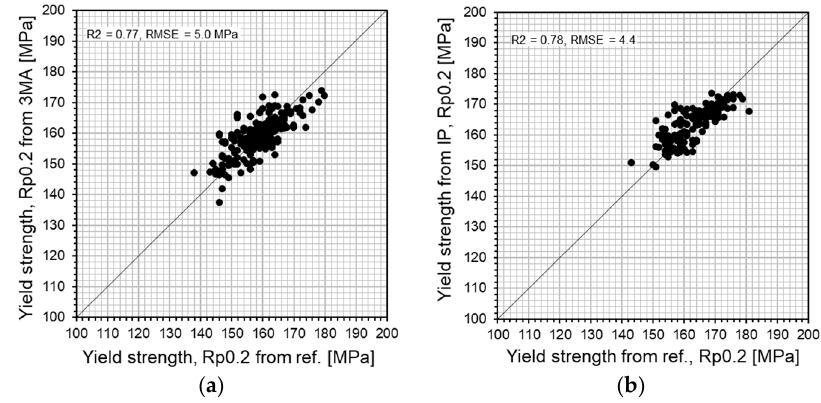
Figure 5. Results of the calibration to yield strength Rp0.2 based on measuring parameters from IP measurements, combined with sheet thickness; nondestructively predicted values of yield strength (from IP) are shown as a function of destructively measured values (from ref.): ( a ) for a steel grade IF_1 and ( b ) for a steel grade IF_2.